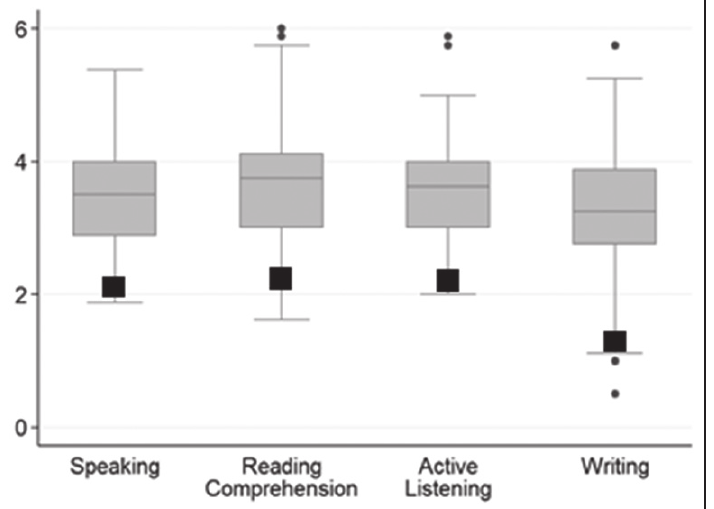
Figure 1 Expert judgments for skills needed among maids and housekeeping cleaners (black squares) relative to all jobs (box plots).